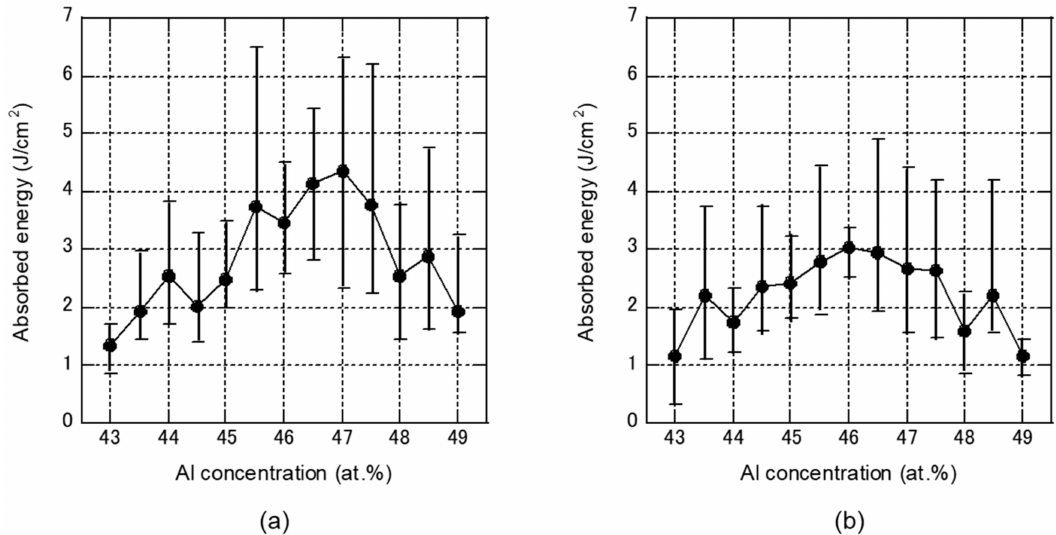
Figure 3. Charpy absorbed energy of the Ti-43–49 at.% Al binary alloy in the ( a ) as-cast state, and ( b ) after heat treatment at 1200 ◦ C for 4 h, followed by cooling at 10 ◦ C/min. The cast TiAl alloys that are already being used or were close to practical use are